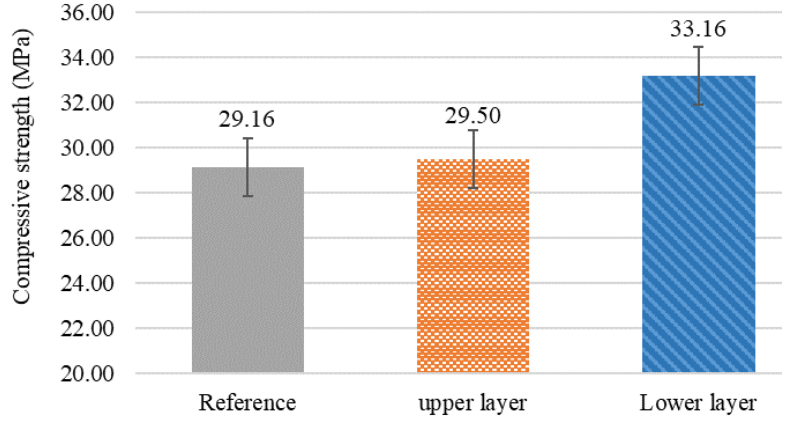
Figure 5. Compressive strength of recycled concrete at 28 days